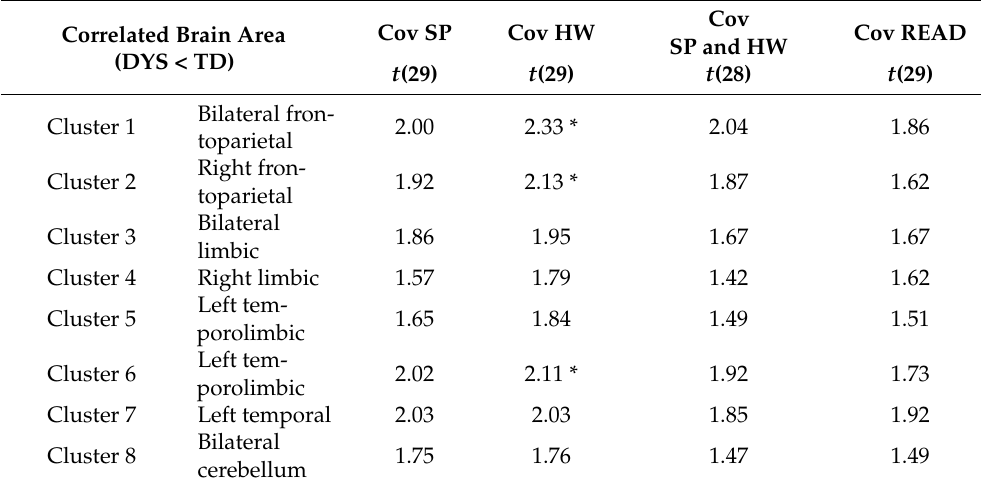
Table 4. Effect of group using spelling, handwriting and reading behaviours as covariates (whole- brain ANCOVAs with the GMFA seed